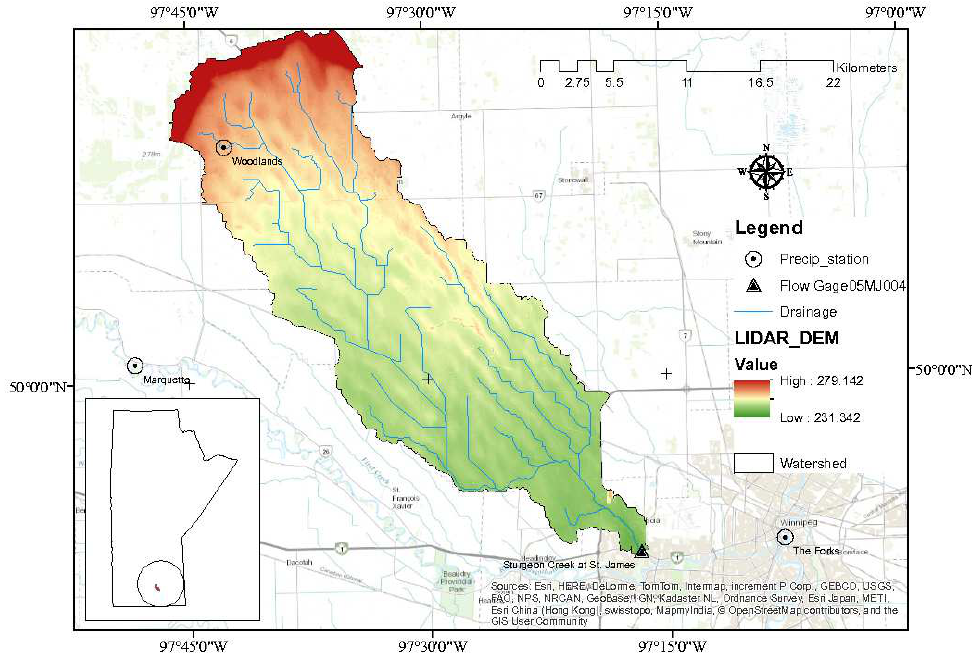
Figure 1. Study area: Sturgeon Creek watershed in Manitoba, Canada. The index map shows the provincial boundary and the location of the watershed in the